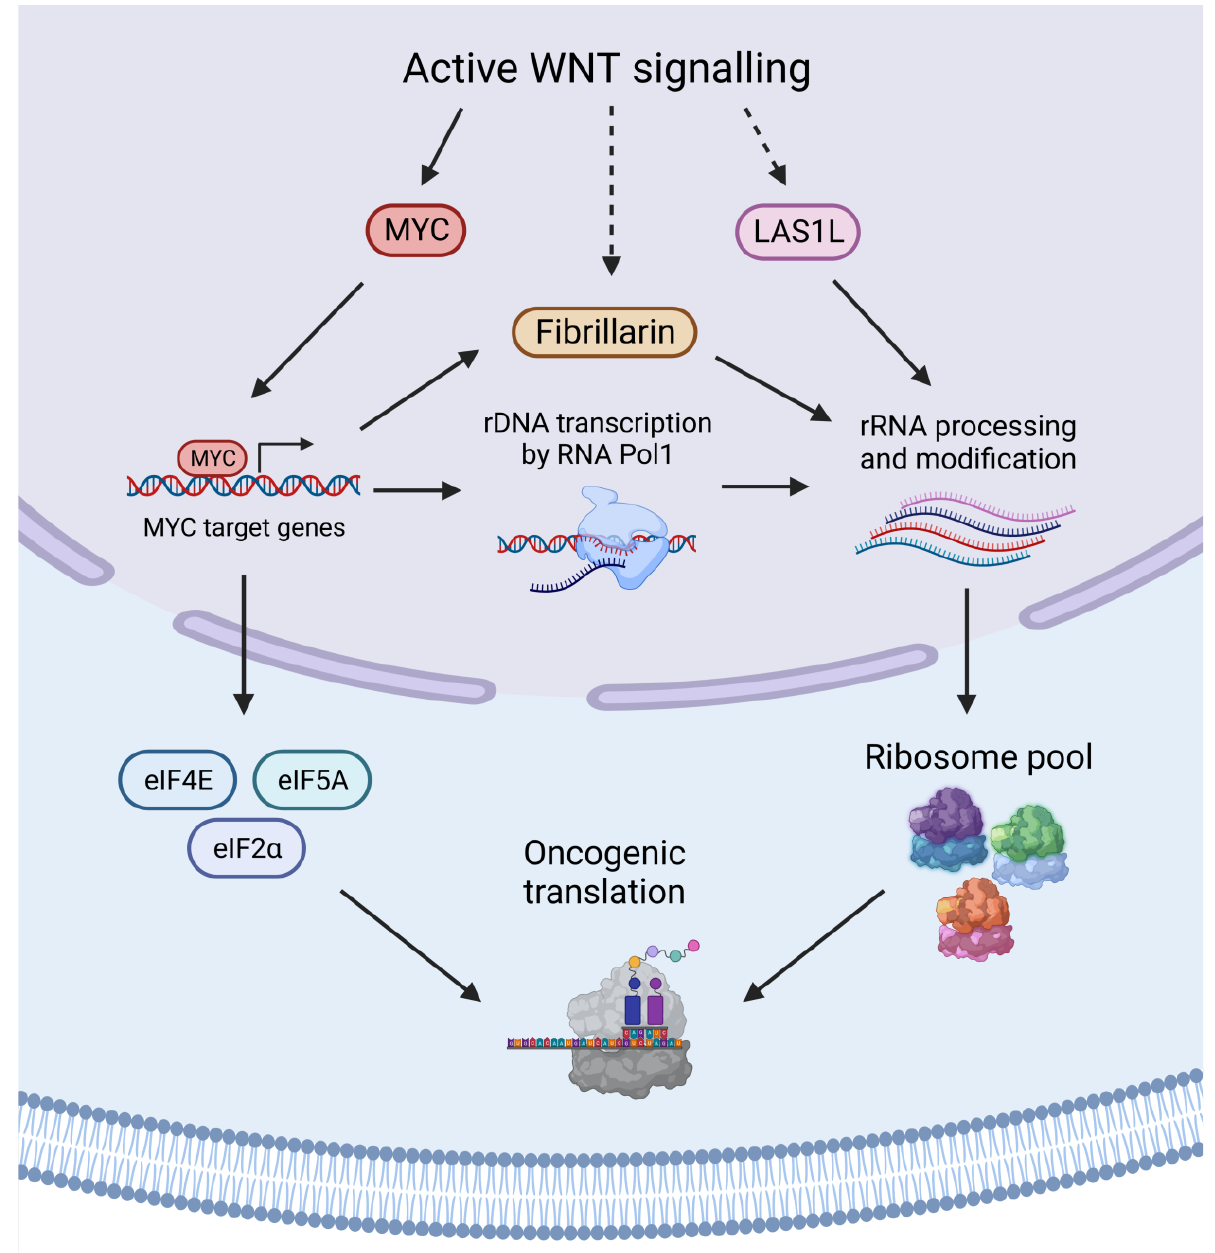
Figure 5. WNT signalling affects ribosome biogenesis and translation. The WNT target genes c-MYC, Fibrillarin, and LAS1L regulate rRNA processing and modification. The transcription factor c-MYC upregulates the transcription of translation initiation factors as well as Fibrillarin and the Polymerase 1 (Pol1)-mediated transcription of rDNA. Differential WNT-driven regulation of ribosome biogenesis may feed the emergence of heterogeneous ribosomes and, together with increased translation factors, potentially affects oncogenic translation. Created with BioRender.com.